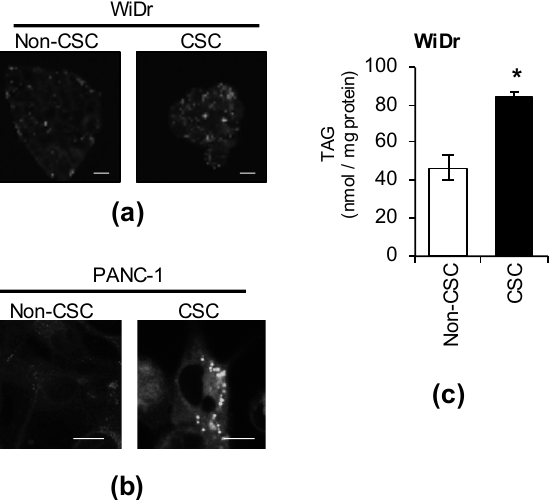
Figure 1. Lipid droplets (LDs) accumulate in cancer stem cells (CSCs). CSCs and non-CSCs were stained using BODIPY (( a ), WiDr) or LipidTOX (( b ), PANC-1). Photographs of the representative images are shown. Scale bars: 10 µ m. ( c ) The intracellular triacylglycerol (TAG) quantities of CSCs and non-CSCs was measured. The values are means ± SDs from triplicate samples of a representative experiment. Similar results were obtained from three independent experiments. Similar results were obtained from two independent biological replicates. * p < 0.05 by the Student’s t